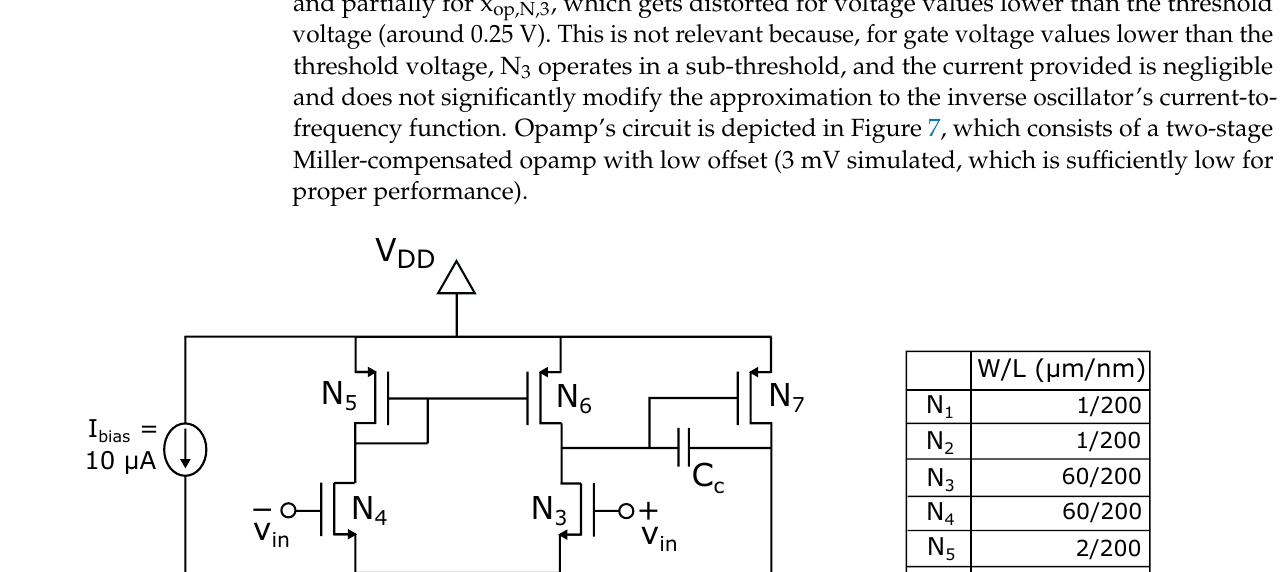
Figure 9. The single-ended peak-to-peak INL error was [ − 0.44 0.26], within 1 LSB. In [40], a fully-synthesizable VCO-ADC is presented, where the INL achieved after digital correction was in the range ( − 1.4 1.49) LSBs and ( − 1.9 1.6) LSBs for simulation and measurement results,